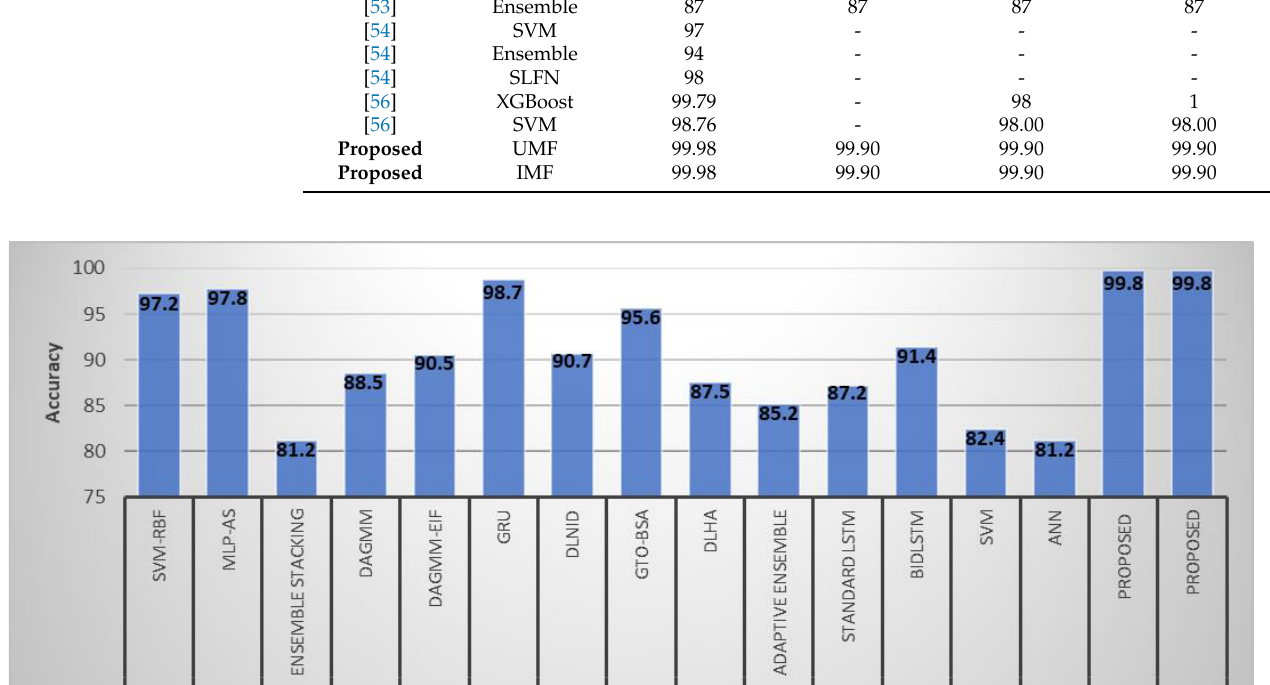
Figure 12. The comparison of accuracy result of our detection model performance and related works of NSL-KDD.